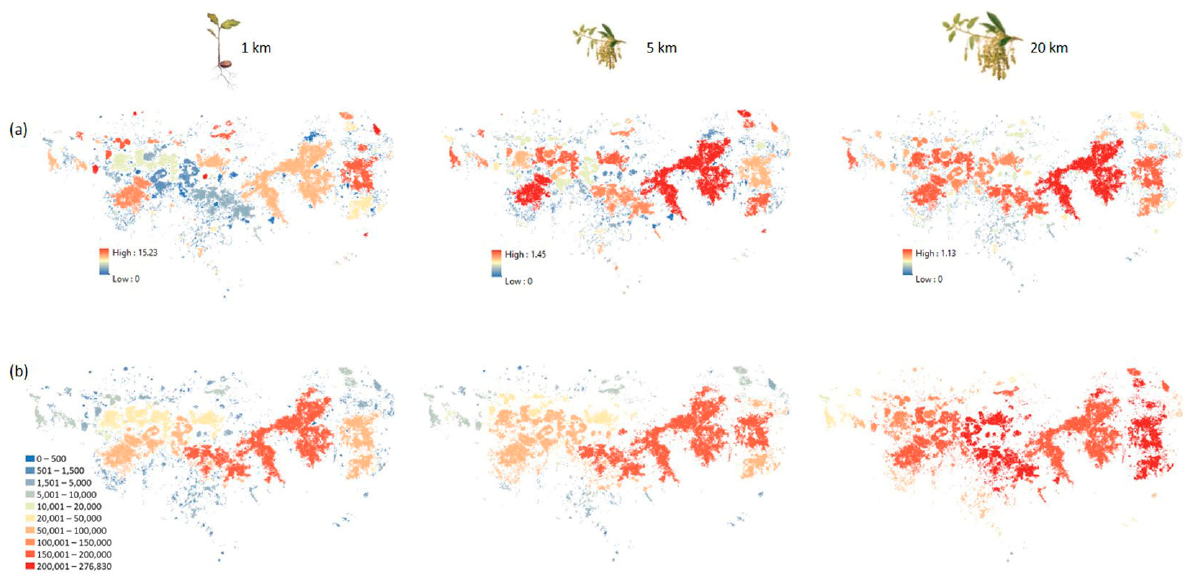
Figure 3. Maps of the temperate forest within the Avocado Belt of Michoac á n, Mexico, showing the prioritizing indexes: CCI f ( a ) and ECA f ( b ). Indices are shown for the dispersal distance thresholds of seeds (1 km) and pollen (5 and 20 km), considering the size as the patch attribute. Values of the indices are indicated by the color of the